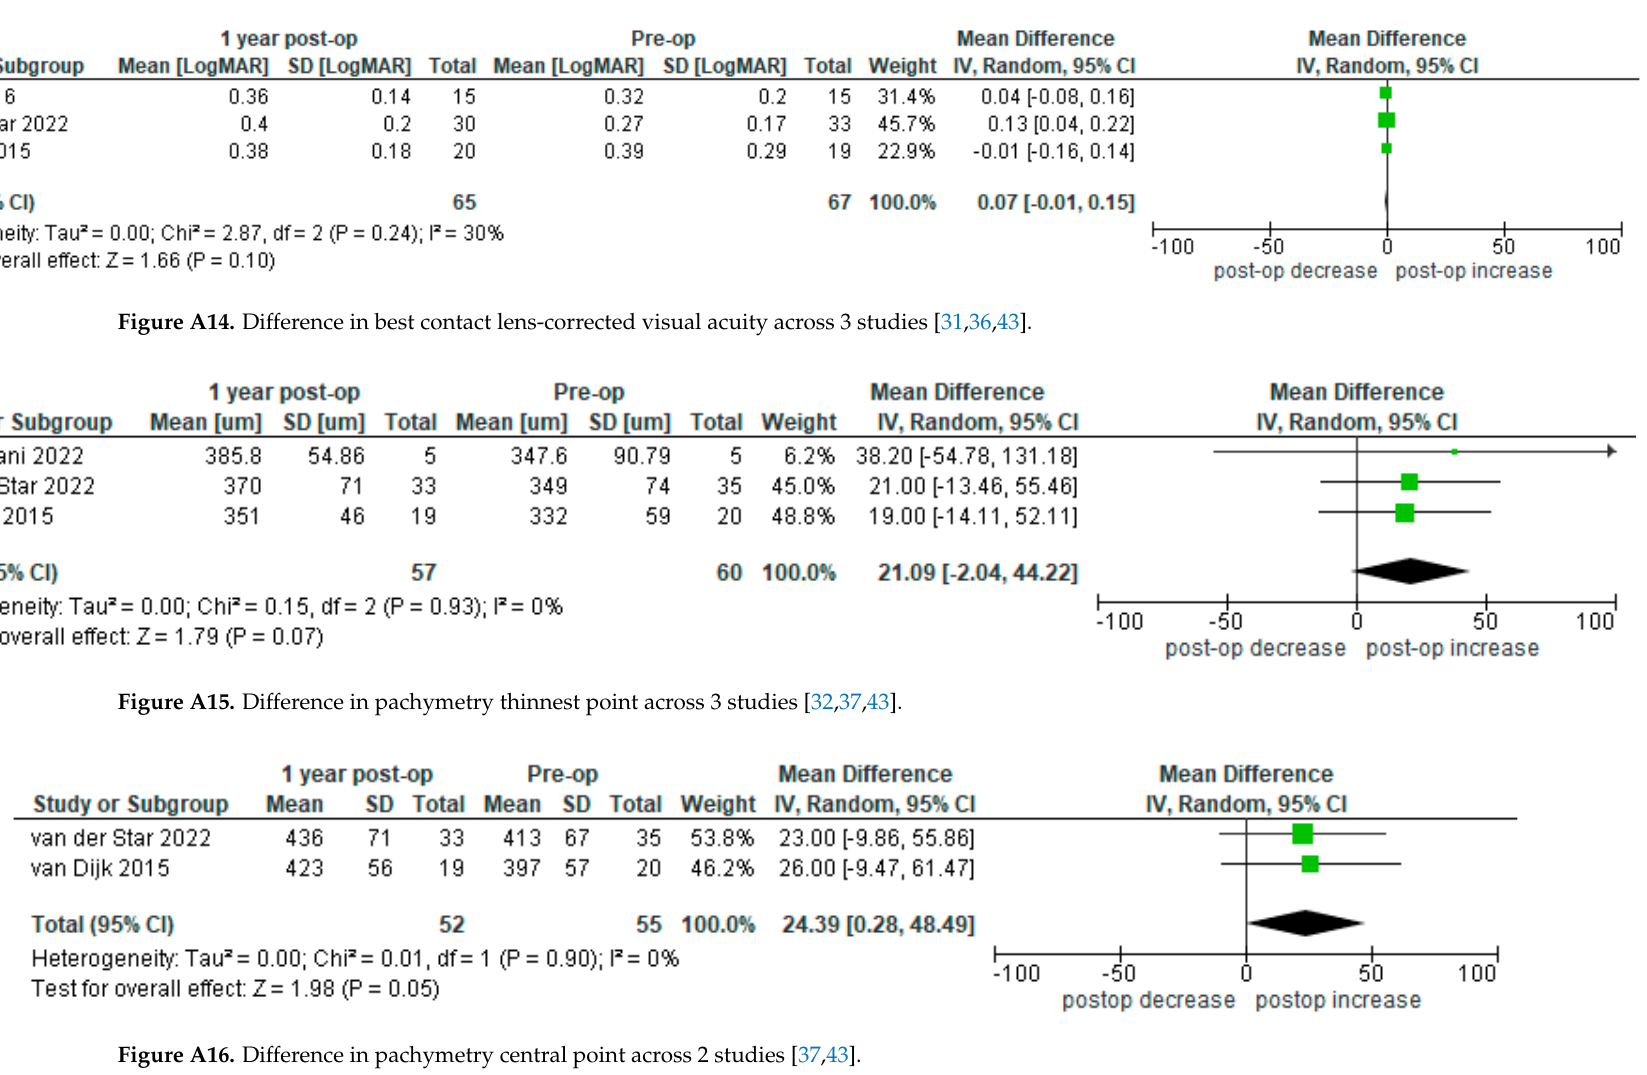
Figure A13. Di ff erence in best spectacle-corrected visual acuity across 3 studies [31,36,43].